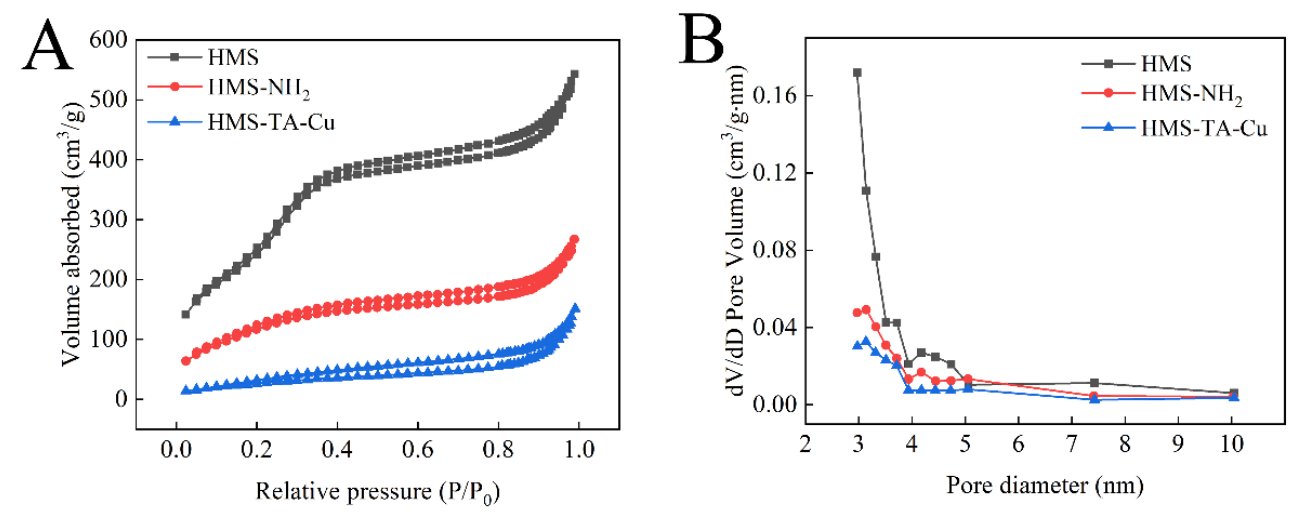
Figure 5. N 2 adsorption isotherms ( A ) and BJH pore size ( B ) of HMS, HMS-NH 2 and HMS-TA-Cu nanoparticles.